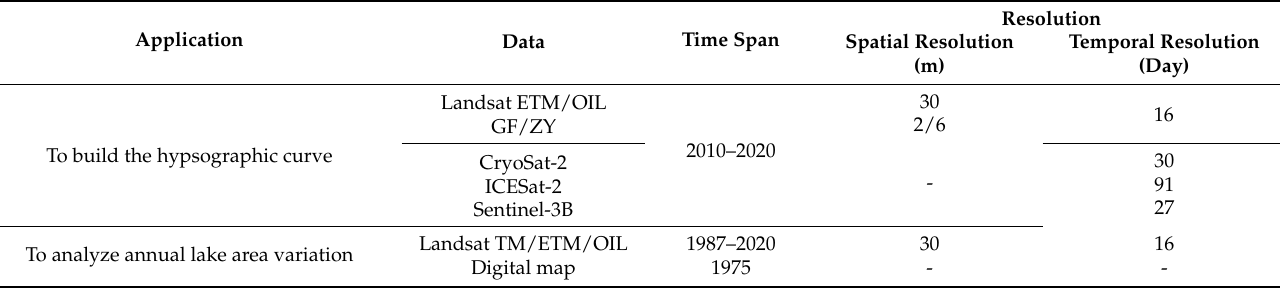
Table 1. Remote-sensing images and satellite altimetry